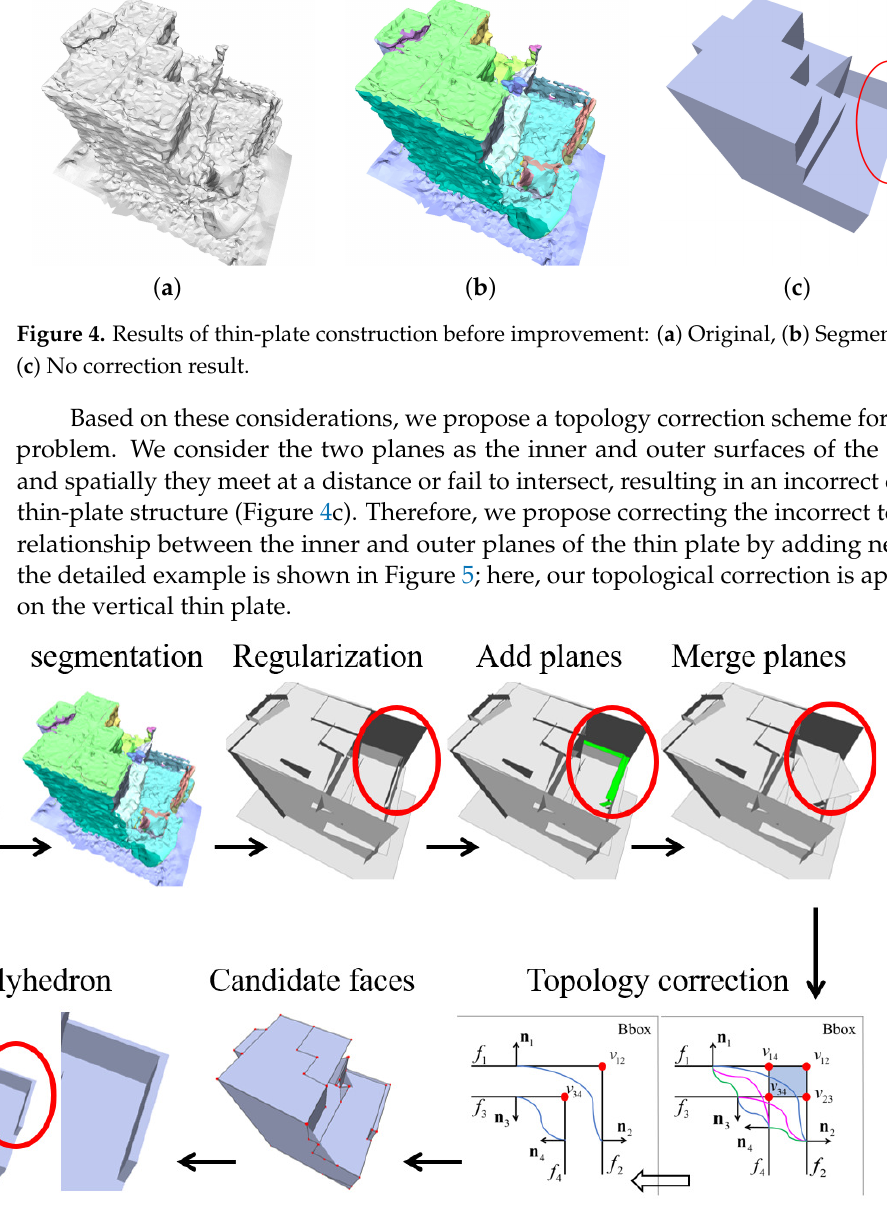
Figure 5. Detailed example of topology correction for thin-plate